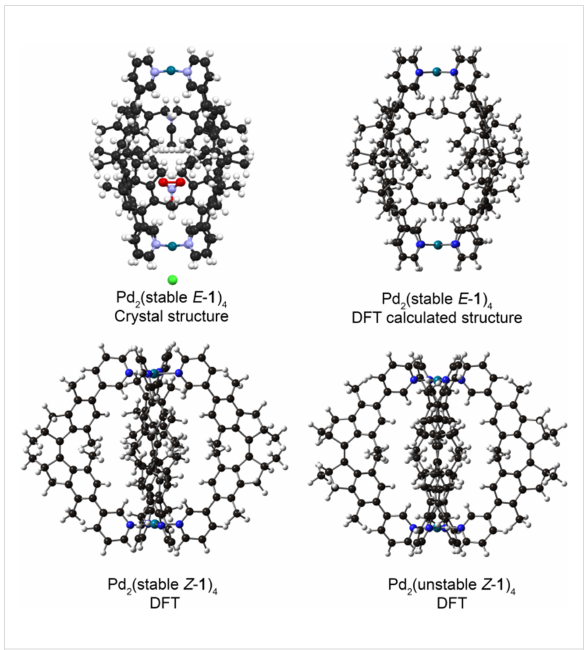
Figure 4: Crystal structure of cage complex Pd 2 (stable E - 1 ) 4 (top left) and DFT optimized structures of cage complexes Pd 2 (stable E - 1 ) 4 , Pd 2 (stable Z - 1 ) 4 and Pd 2 (unstable Z - 1 ) 4 . For clarity only one of the enantiomeric cages was depicted on the figure (carbon – black, nitrogen – blue, oxygen – red, palladium – cyan, chlorine – green, hydrogen –